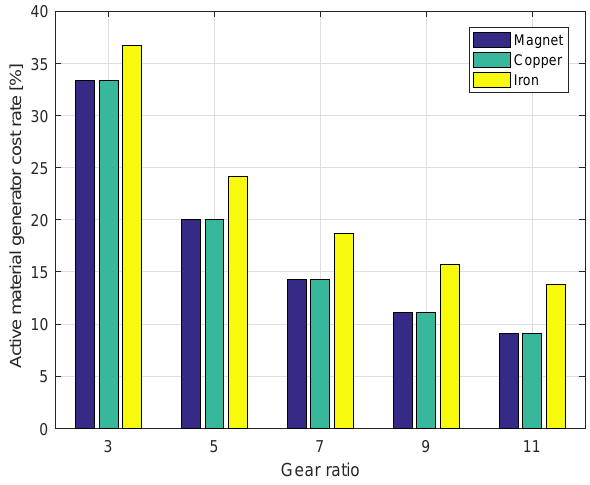
Figure 18. Active material geared generator cost compared to direct drive (DD) generator.